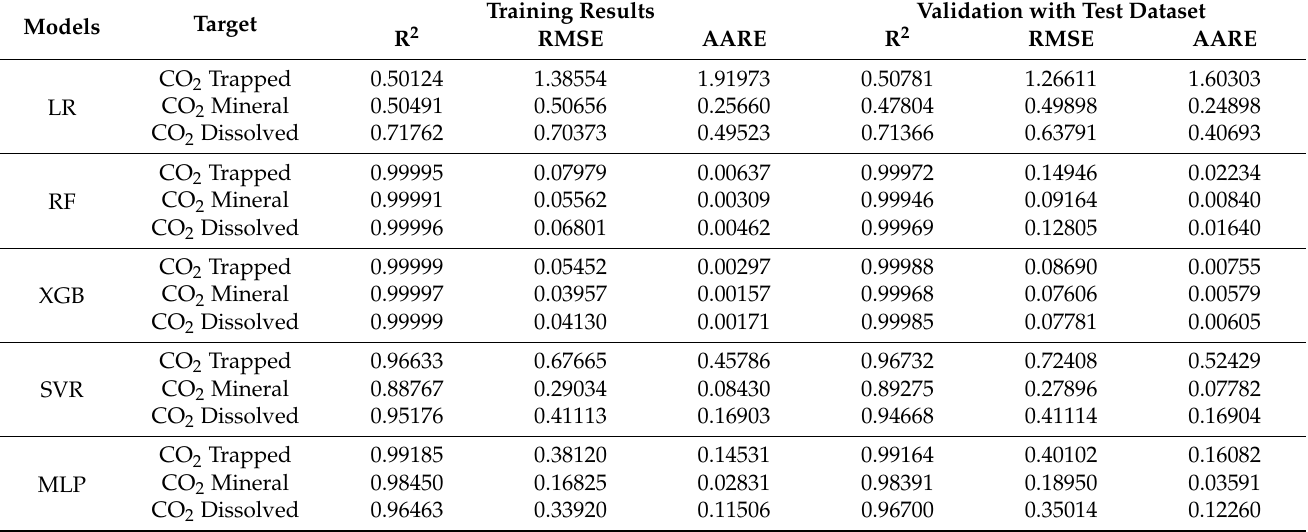
Table 4. The statistical accuracy of the proposed machine learning methods in determining CO 2 Trapped, CO 2 Dissolved, and CO 2